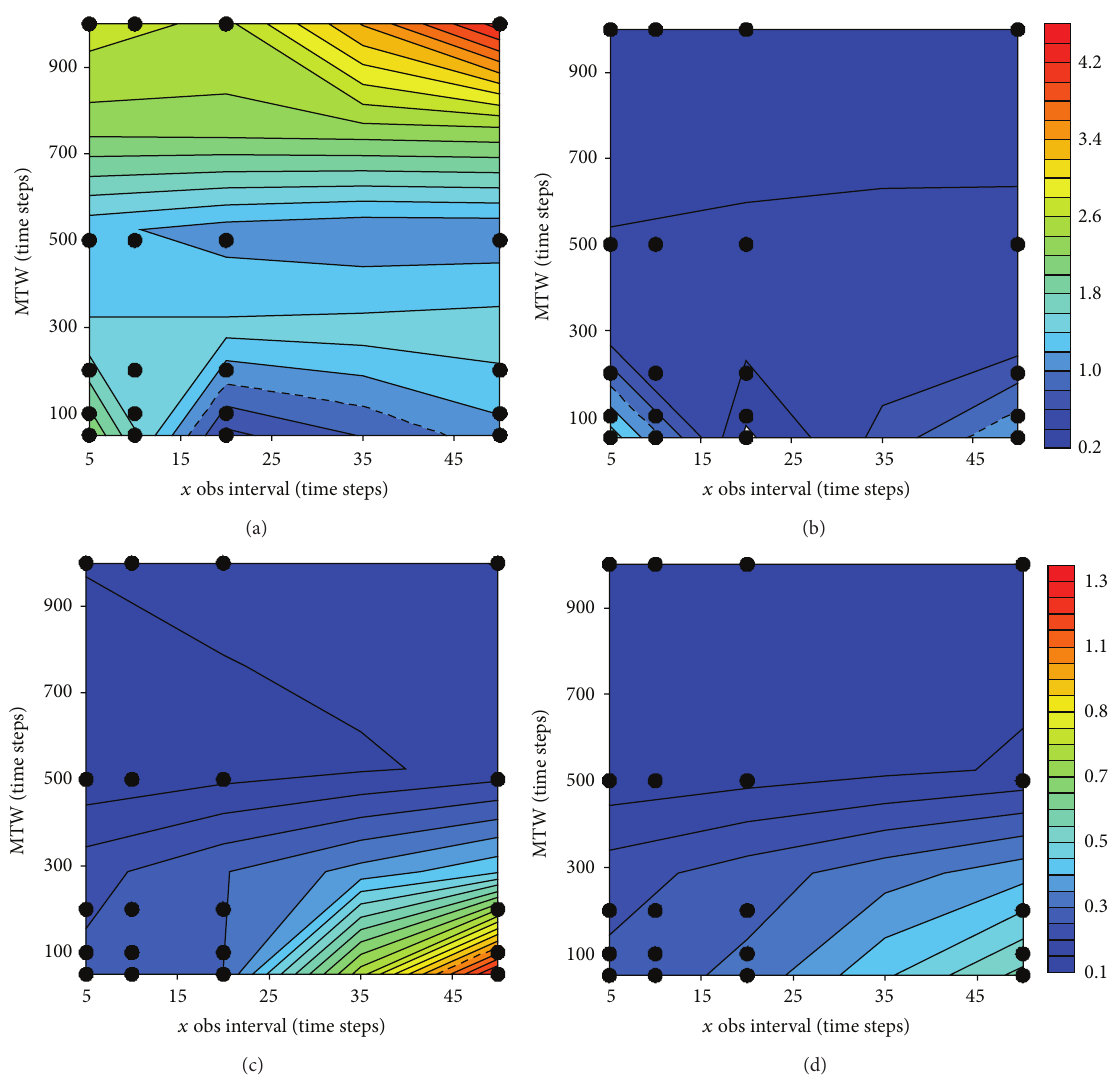
Figure 3: Time-averaged normalized absolute errors of (a) 𝑐 2 in EXP-2, (b) 𝑐 2 in EXP-4, (c) 𝑐 1 in EXP-3, and (d) 𝑐 1 in EXP-4 of the 4D-Var CPE. The absolute errors of 𝑐 2 and 𝑐 1 are normalized by their initial errors, that is, 0.1 and 0.01, respectively. The 𝑥 -axis is the atmospheric observational interval while the 𝑦 -axis denotes the minimization time window (MTW) in 4D-Var. The black solid circles stand for the scatter points used to create the contours. The dashed curve represents the 1.0 contour. Panels (a) and (b) use the upper shade scale while panels (c) and (d) use the lower shade scale. Note that 1 Time Unit = 100 time steps. EXP-1 only performs state estimation. EXP-2 instantaneously conducts state estimation and parameter estimation of 𝑐 2 . EXP-3 instantaneously conducts state estimation and parameter estimation of 𝑐 1 . EXP-4 instantaneously conducts state estimation and parameter estimations of 𝑐 1 and 𝑐 2